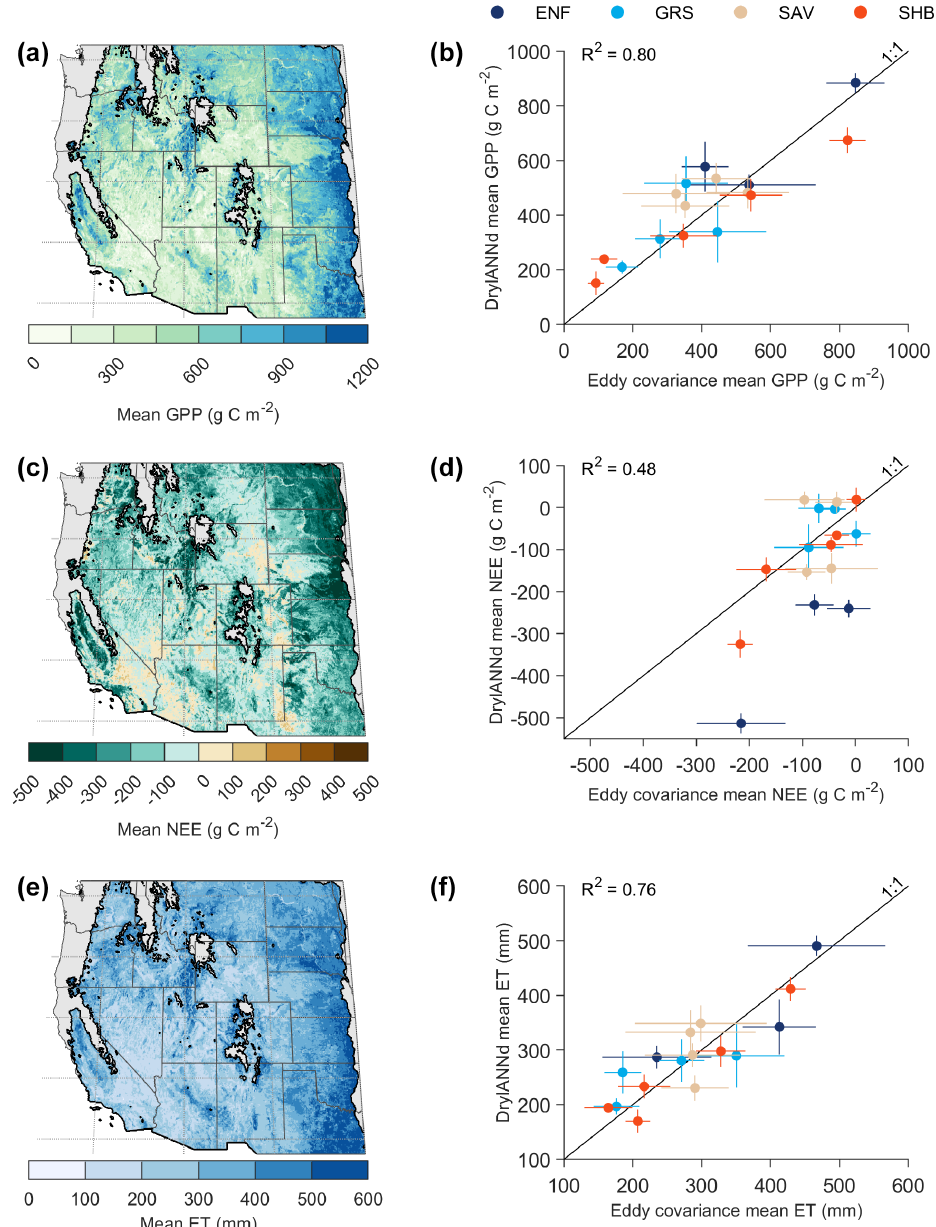
Figure 4. Spatial patterns and spatial validation of mean warm-season (April–October) GPP (a,b) , NEE (c,d) , and ET (e,f) predicted by DrylANNd during 2015–2020. Maps show the regional DrylANNd predictions, with the black outline indicating the region classified as dryland ( P/ PET ≤ 0.75). Scatterplots show mean ( ± 1 standard deviation) warm-season fluxes predicted by DrylANNd and measured by eddy covariance at the 16 AmeriFlux sites that had complete records from 2015–2020, with points colored by vegetation type. For purposes of calculating annual means and standard errors, missing monthly data were filled with a spline